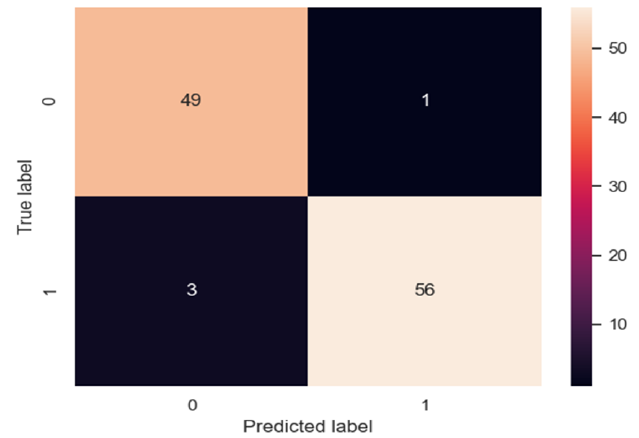
Figure 1. Confusion matrix.